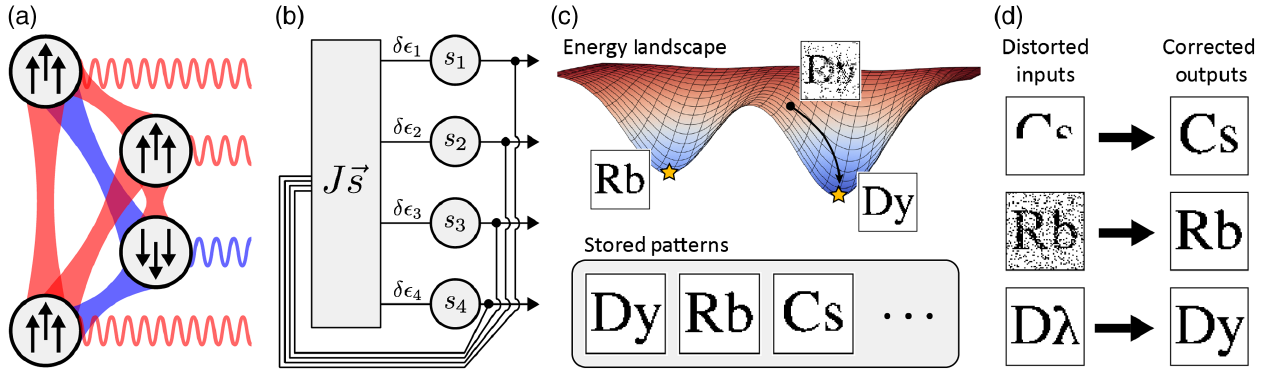
FIG. 3. (a) All-to-all, sign-changing connectivity between spin ensembles is achieved via photons propagating in superpositions of cavity modes. Blue and red indicate ferromagnetic versus antiferromagnetic J links. Only four nodes are depicted. Individual spins ij align within an ensemble due to superradiance, while ensembles organize with respect to each other due to J coupling. Cavity emission ij allows for holographic reconstruction of the spin state: Red and blue fields are π out of phase, allowing discrimination between up and 1 that down spin ensembles. (b) The spin ensembles realize a Hopfield neural network: a single-layer network of binary neurons s i ¼ (cid:2) are recurrently fed back and then subjected to a linear transform J and threshold operation at each neuron. (c) The Hopfield model exhibits an energy landscape with many metastable states. Each local minimum encodes a memory spin configuration (pattern) surrounded by a larger basin of attraction of similar spin states. Energy minimizing dynamics drive sufficiently similar spin configurations to the stored local minimum. There is a phase transition from an associative memory to a spin glass once there are too many memories, i.e., when so many minima exist that basins of attraction vanish. (This transition might be a crossover in the CCQED system; see the text.) (d) Schematic of the associative memory problem. Multiple stored patterns (e.g., images of element symbols) may be recalled by pattern completion of distorted input